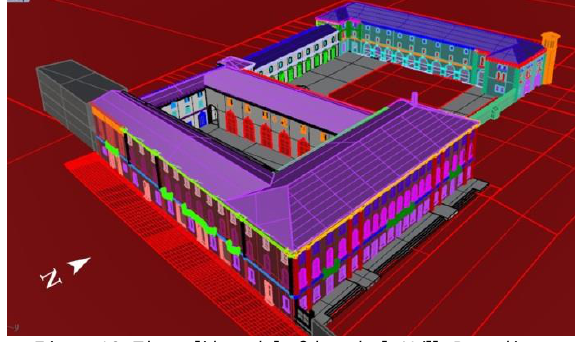
Figure 18: The solid model of the whole Villa Revedin- Bolasco generated in Rhino